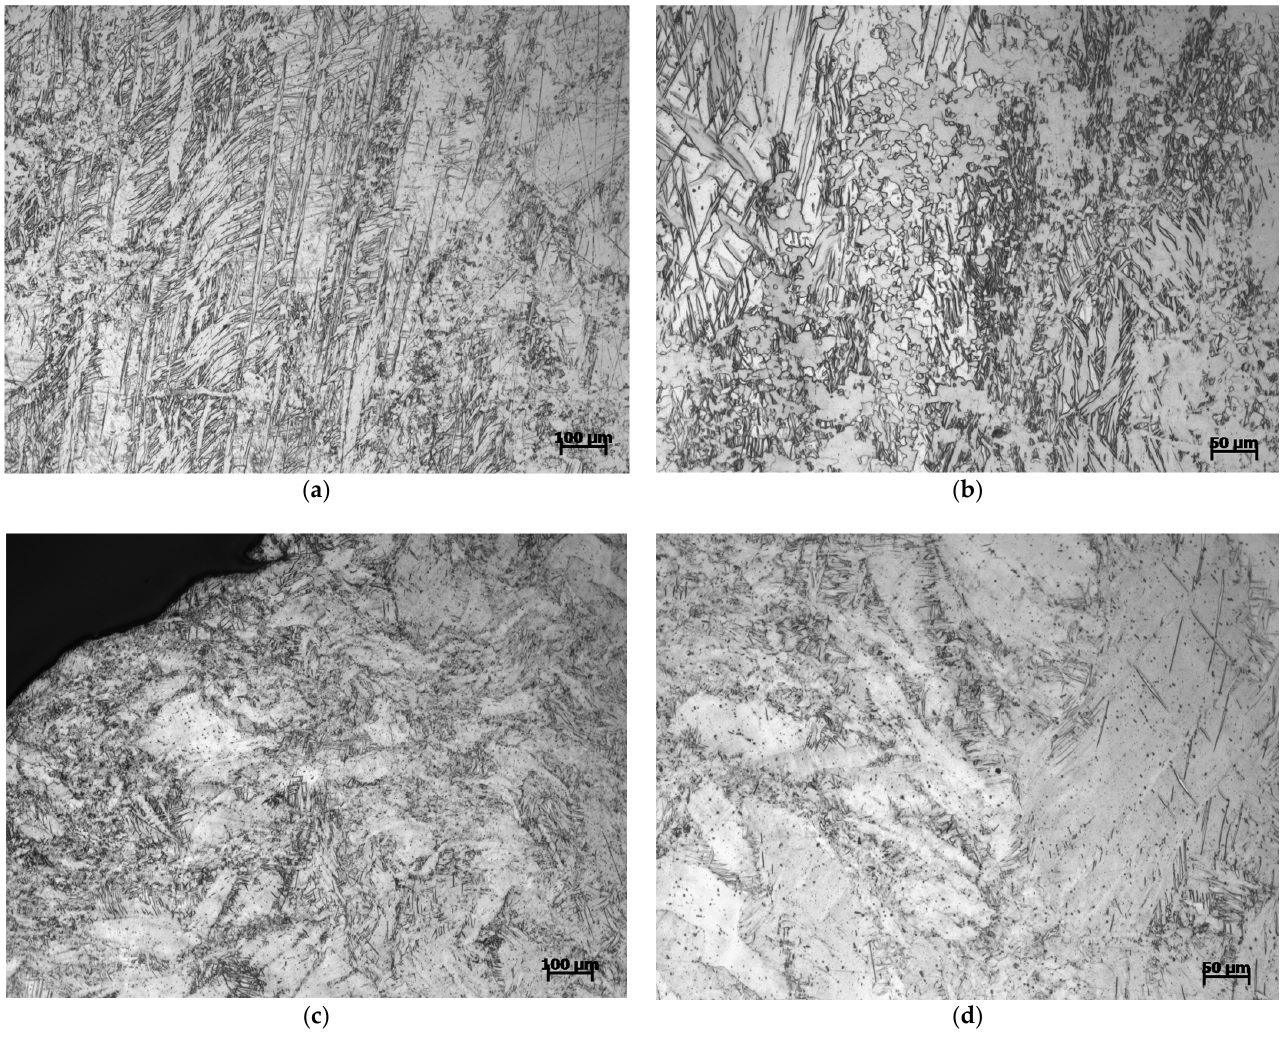
Figure 11. Microstructure of Mg-Al-Ca-Mn alloy compressed in the ND direction under ( a,b ) 700/s strain rate and ( c,d ) 1400/s strain rate.